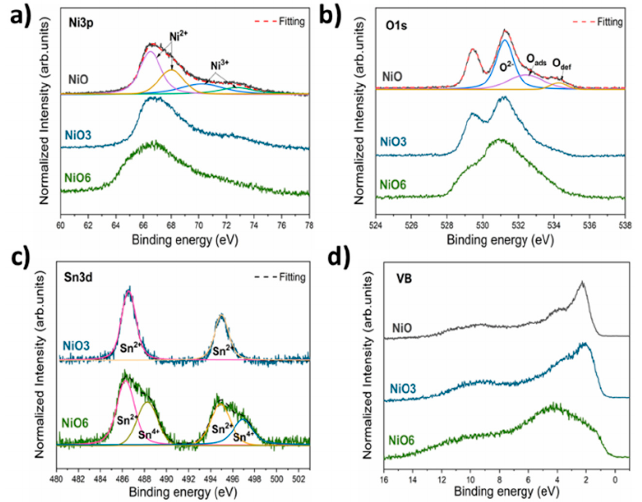
Figure 7. XPS spectra from ( a ) Ni 3p, ( b ) O 1s, ( c ) Sn 3d core levels and ( d ) valence band region acquired for the NiO, NiO3 and NiO6